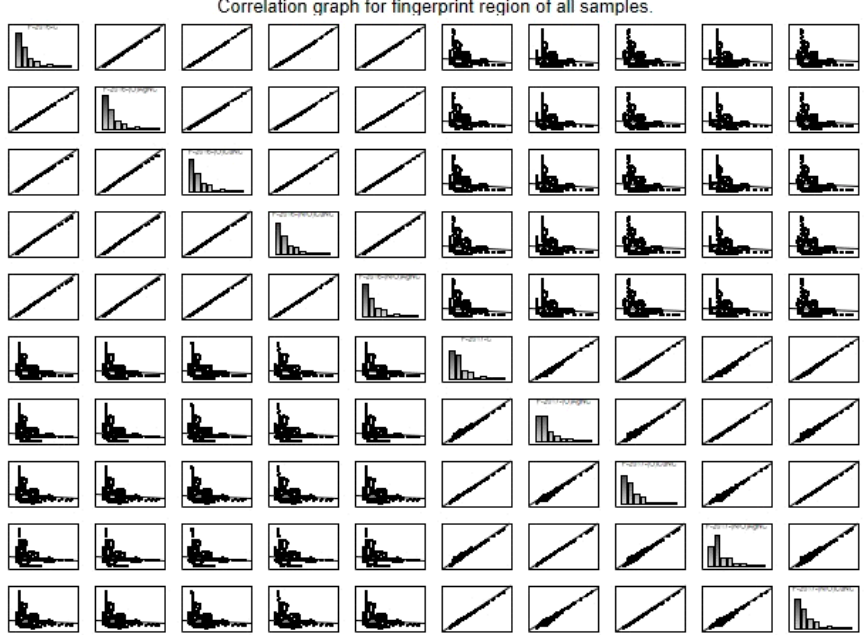
Figure 4. Plot of the pairwise correlations between the oil samples from the FT-IR spectra. Diagonal values are measures of sampling adequacy for individual fingerprint regions of oil samples; off-diagonal are anti-image correlations. In the case of high values of correlation, we have (nearly) linear dependence, otherwise nonlinear.